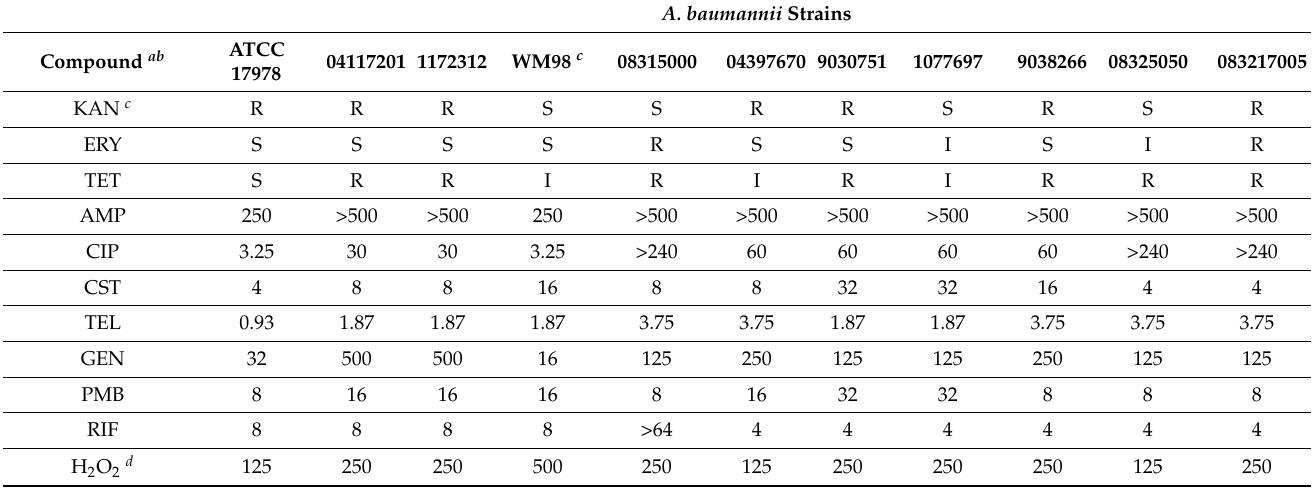
Table 1. Antimicrobial resistance profiles of Acinetobacter baumannii clinical strains. A. baumannii Strains